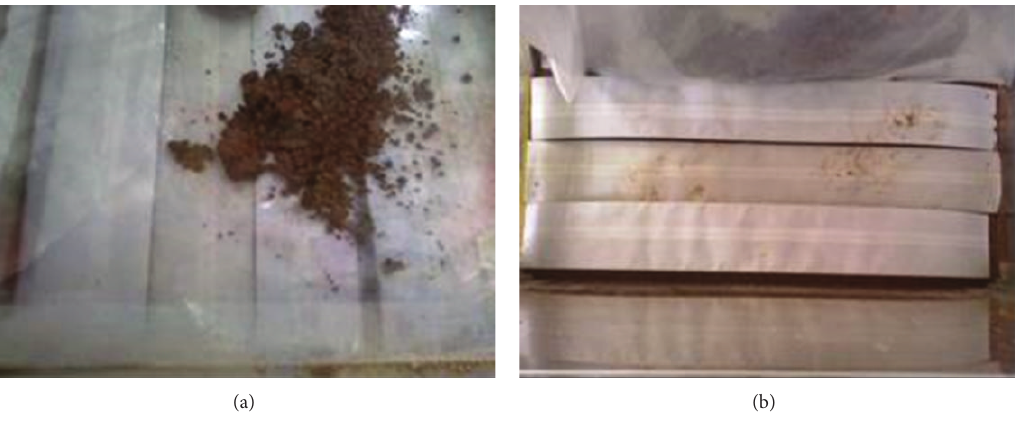
Figure 10: New antidrainage